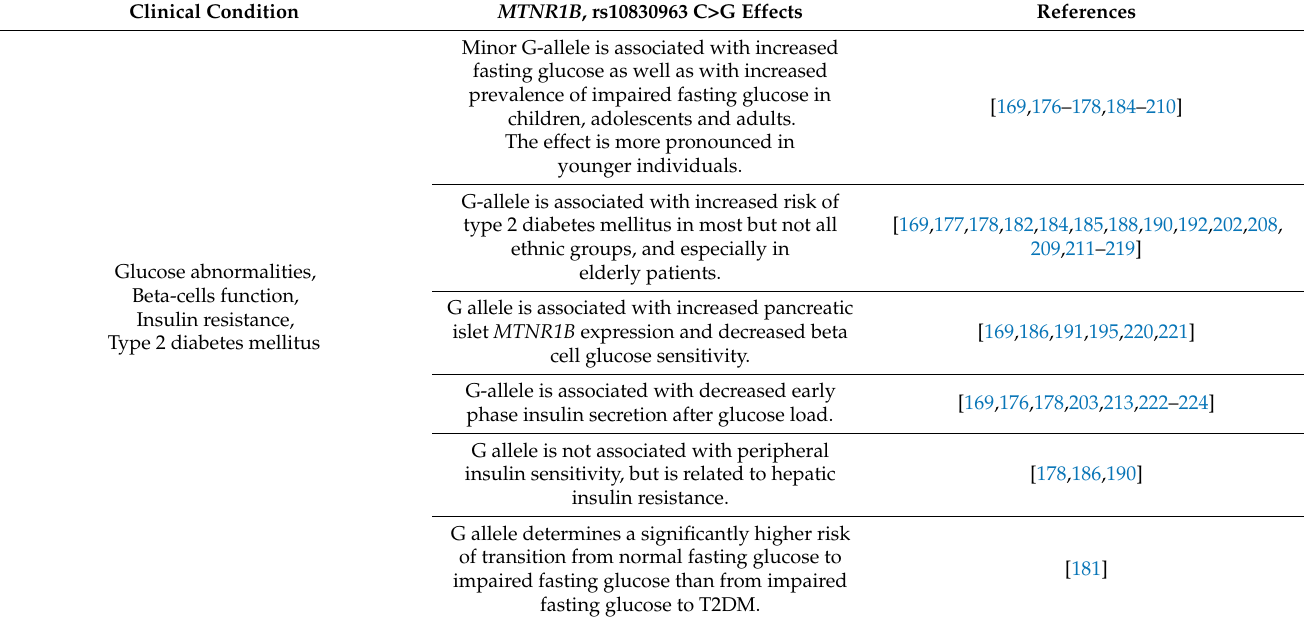
Table 2. Clinical significance of MTNR1B , rs10830963 C>G